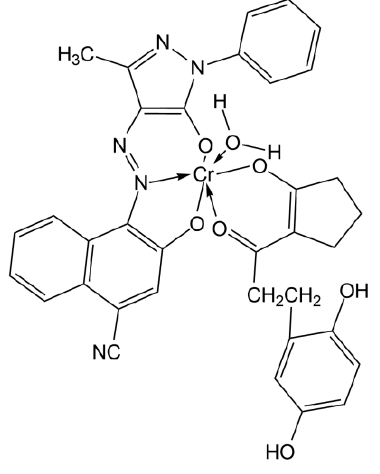
Figure 7. Magenta a chromium complex of an azo pyrazolone of type.